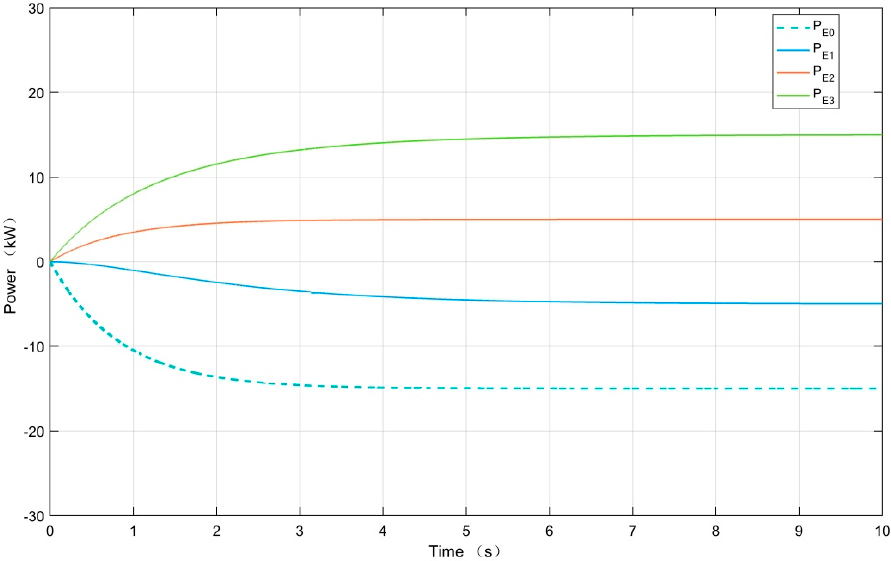
Figure 7. Exchange power of modules.